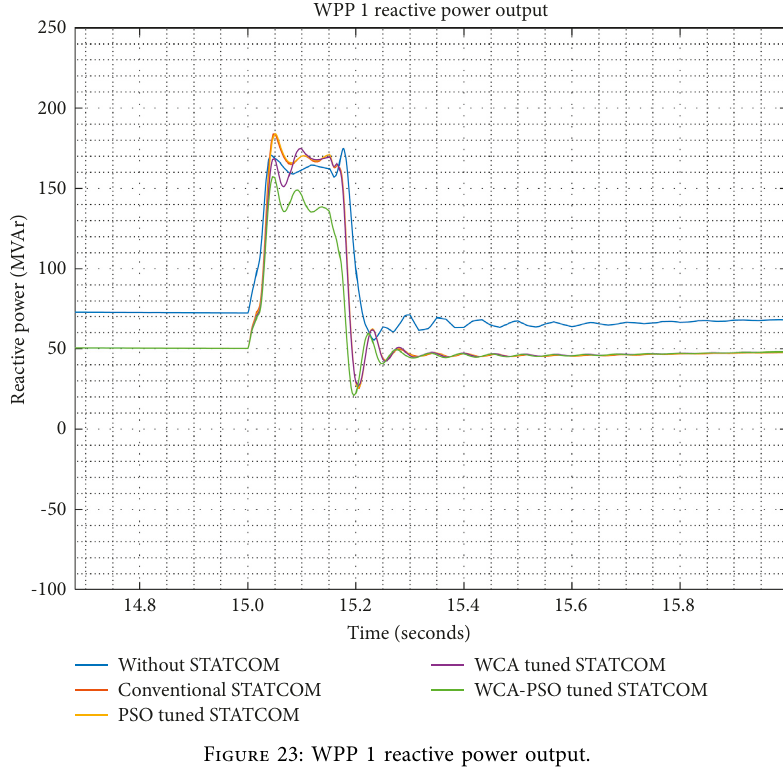
Figure 23: WPP 1 reactive power output.